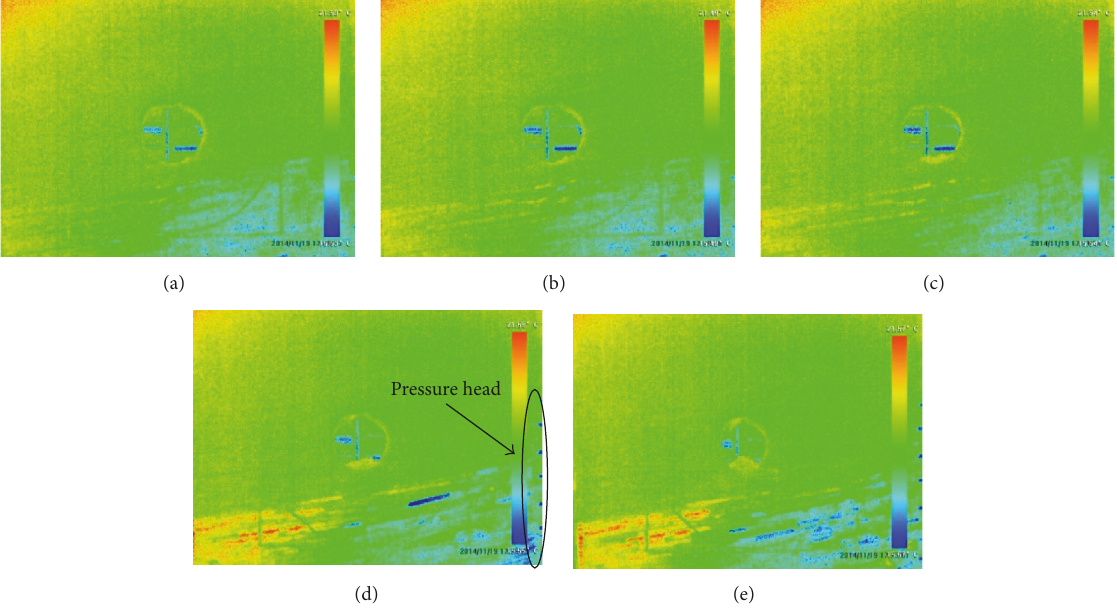
Figure8:Infraredimagesofthedestroyedprocess;(a)–(e)areinfraredimagestakenaftertheeighthloading,comingalongwiththedestroyed